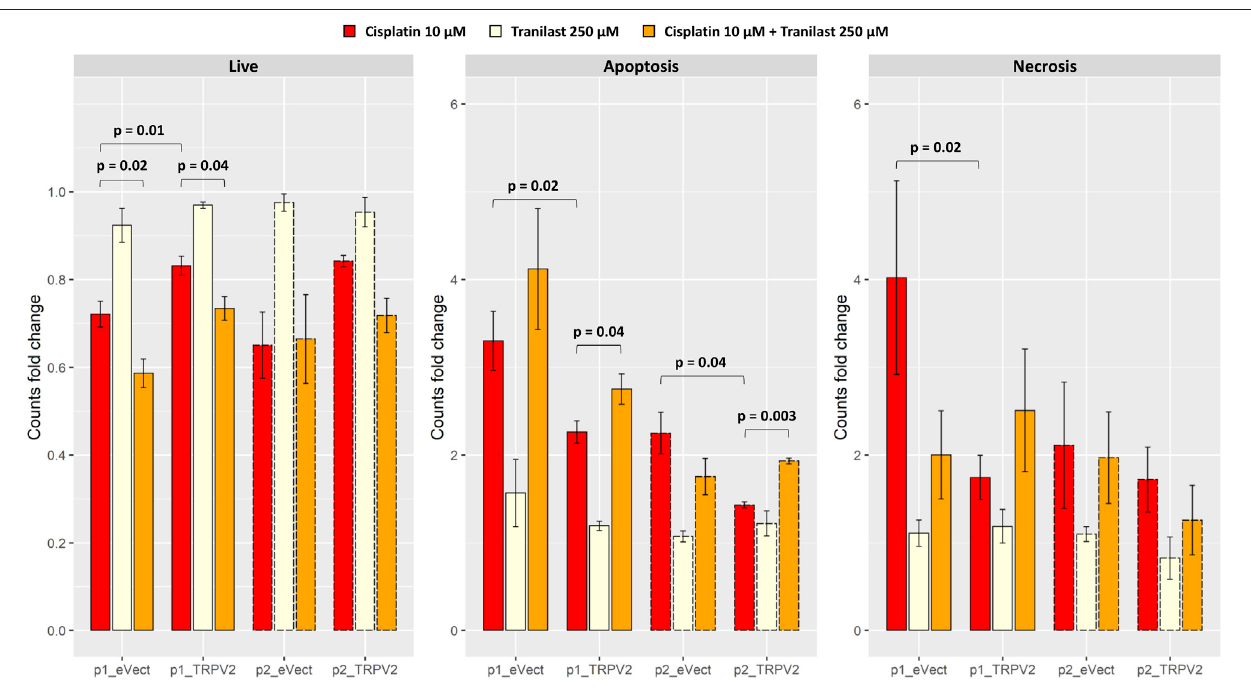
FIGURE6 | Effectofexogenous expression of TRPV2 calcium channel in the cisplatin-sensitive AGSGCcell line. Cisplatin-induced apoptosis intransformed AGS cell line pools expressing exogenous TRPV2 was assessed by fl ow cytometry. t -test was used to assess the signi fi cance of comparison between mean fold changes from three replicates (solid and dashed lines distinguish between the fi rst and second